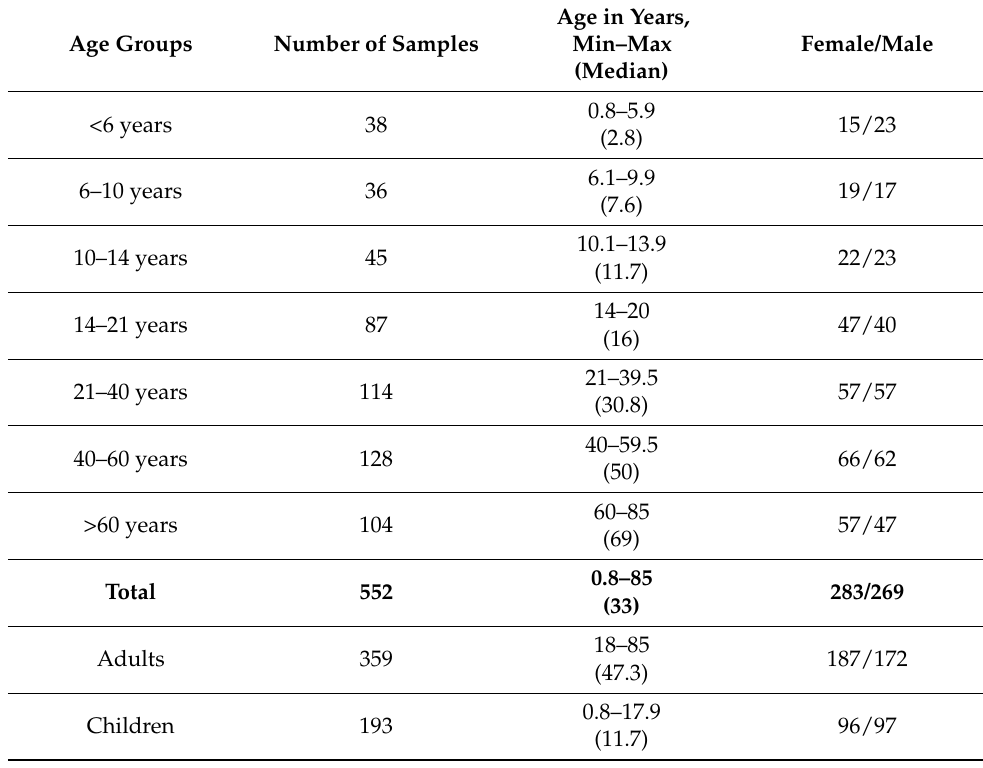
Table 1. Characteristics of the study participants by age